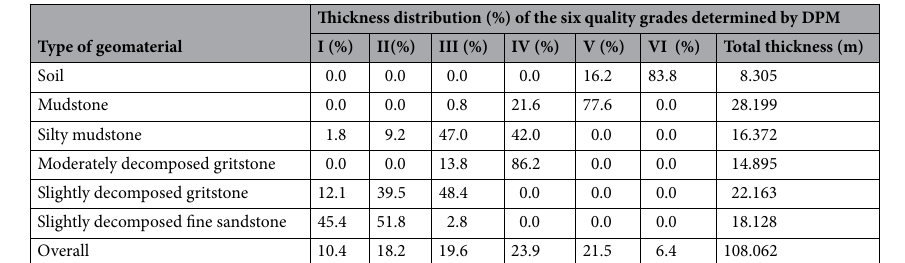
Table 3. Percentage distribution of zone thicknesses with the six basic strength quality grades for the ground geomaterials measured with digitalization data.